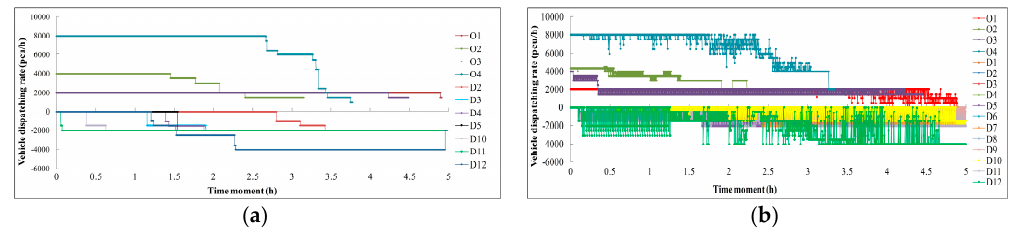
Figure 8. The emergency material dispatching result in the static situation: ( a ) single-objective; ( b ) multi-objective, where a positive value is the departure rate and a negative value is the arrival rate.